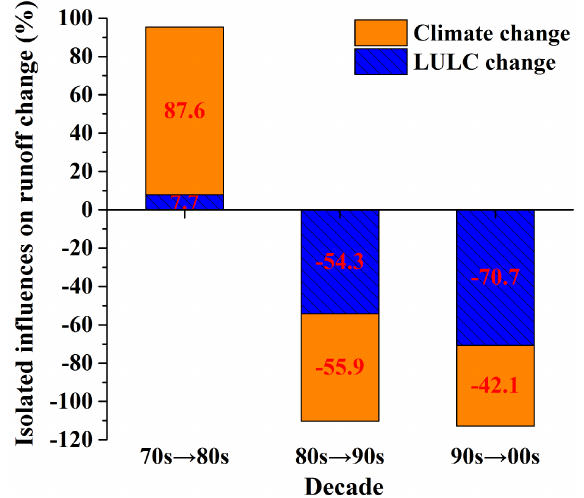
Figure 9. Isolated impacts of LULC and climate changes on surface runoff. Positive values indicate that runoff increased due to these factors, whereas negative values indicate that runoff decreased due to these factors. The summation of the isolated influences is not equal to 100% due to simulation uncertainty (see Sect. 4.2 for de-